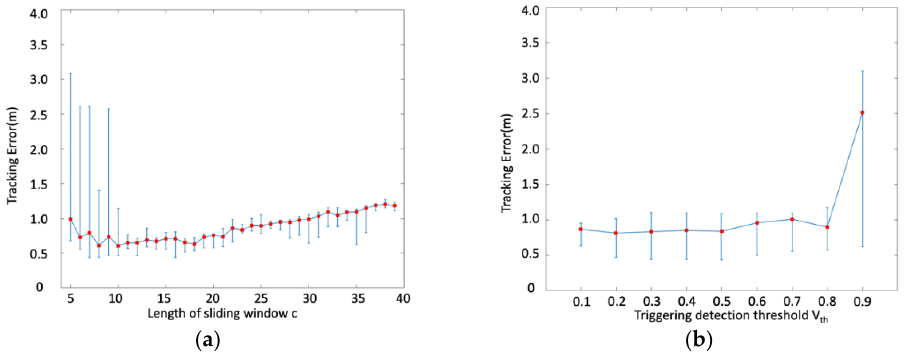
Figure 8. Tracking errors as functions of the length of the sliding window and triggering detection threshold for the proposed GM scheme ( a ) length of sliding window c and ( b ) triggering detection threshold V th . The central marks indicate the medians of tracking errors. The lower and upper bars indicate the 0th and 75th percentiles, respectively.